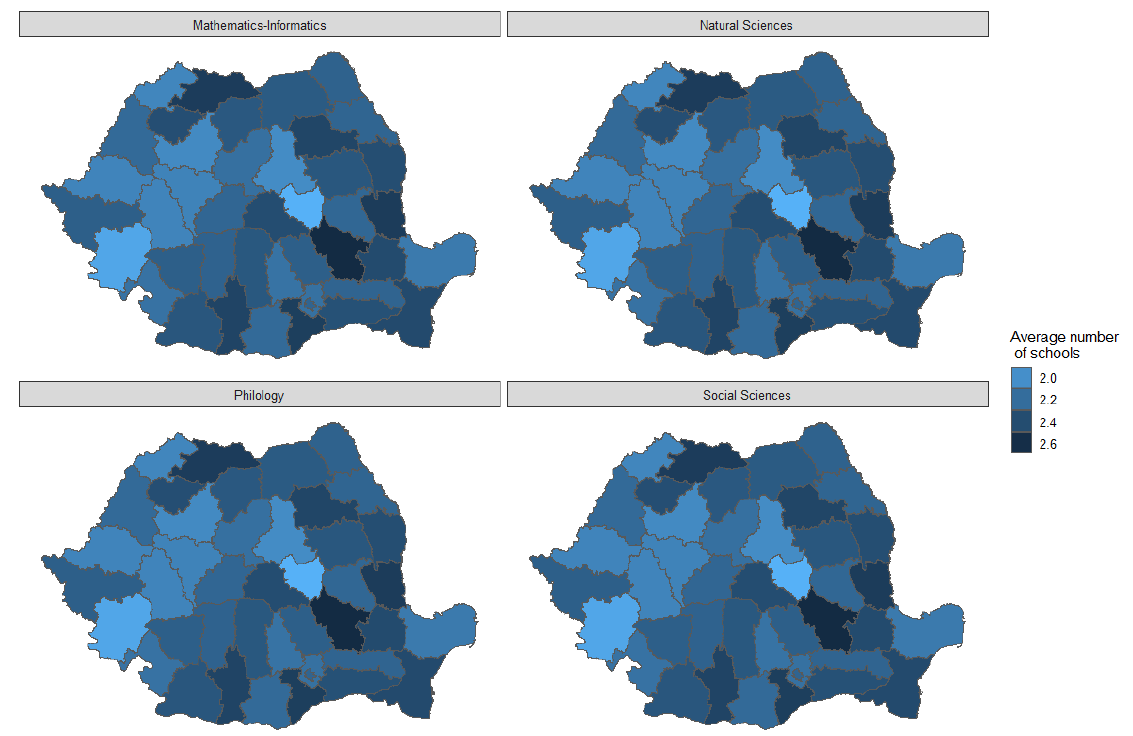
Figure 4. Average number of feeder schools per county.